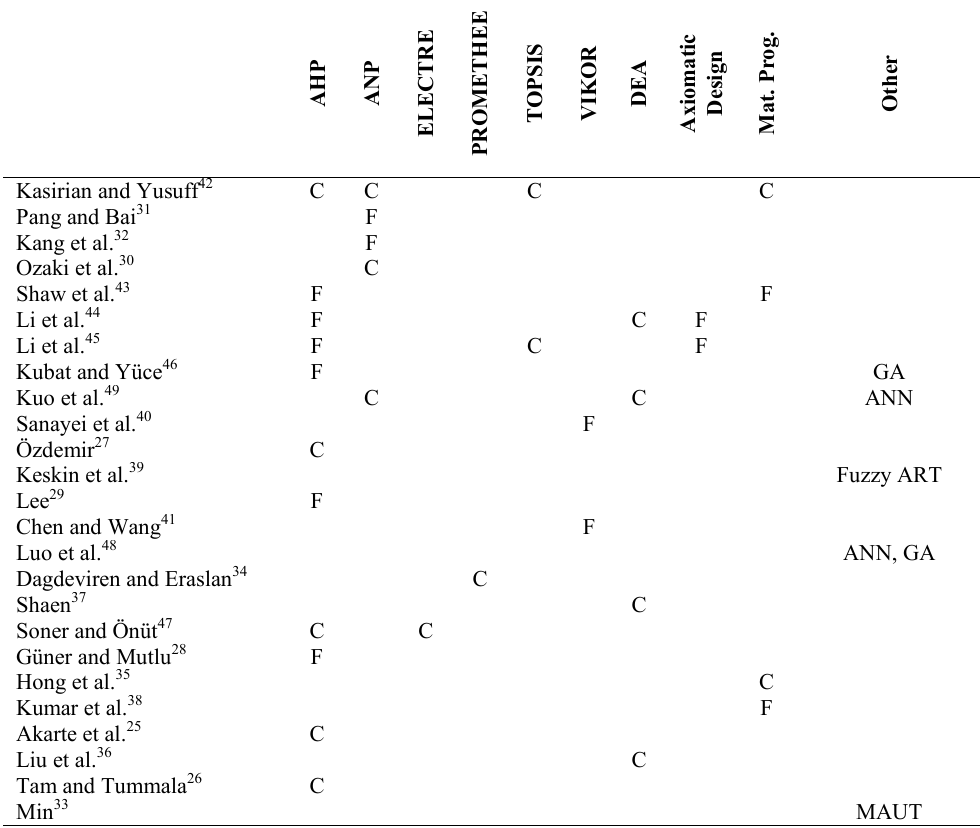
Table 1. Examples of supplier selection studies and their